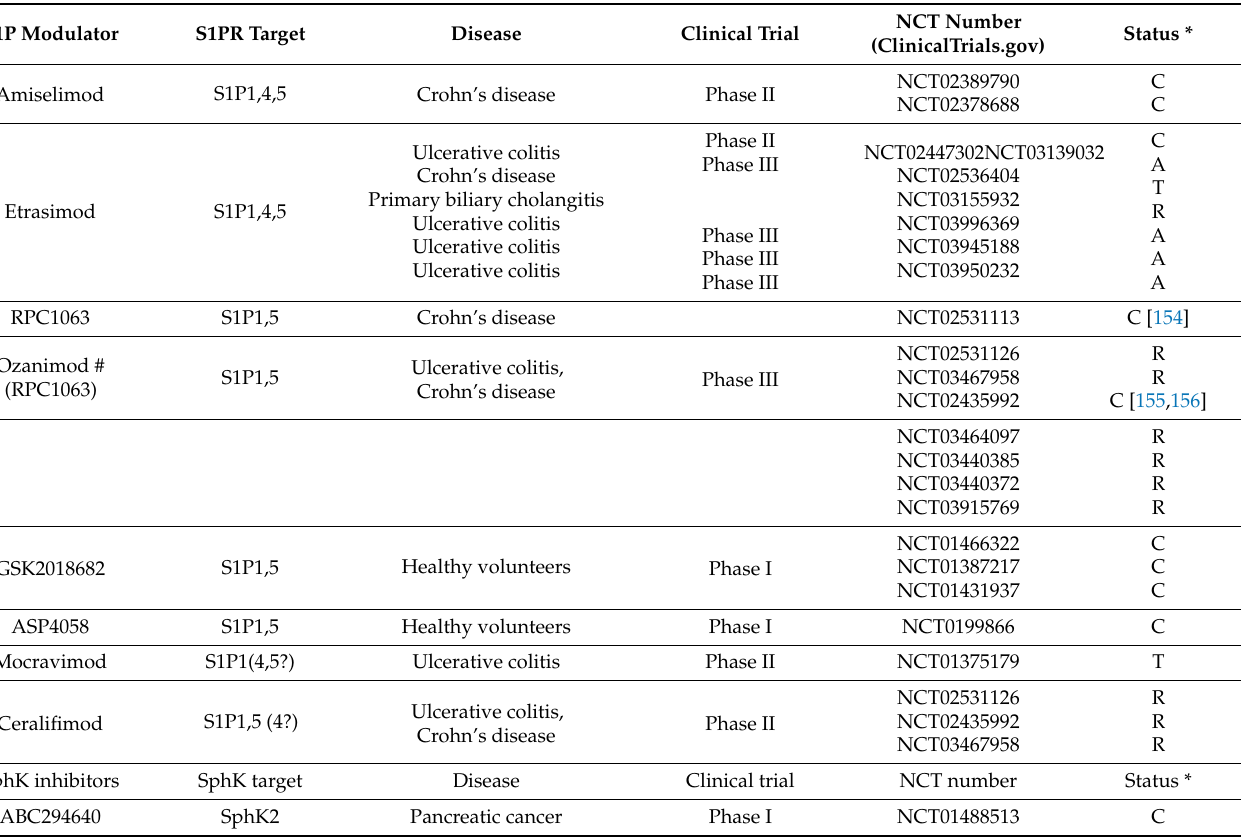
Table 3. Clinical trials using S1PR and SphK modulators for the treatment of inflammatory gastric- intestinal tract- and organ-related